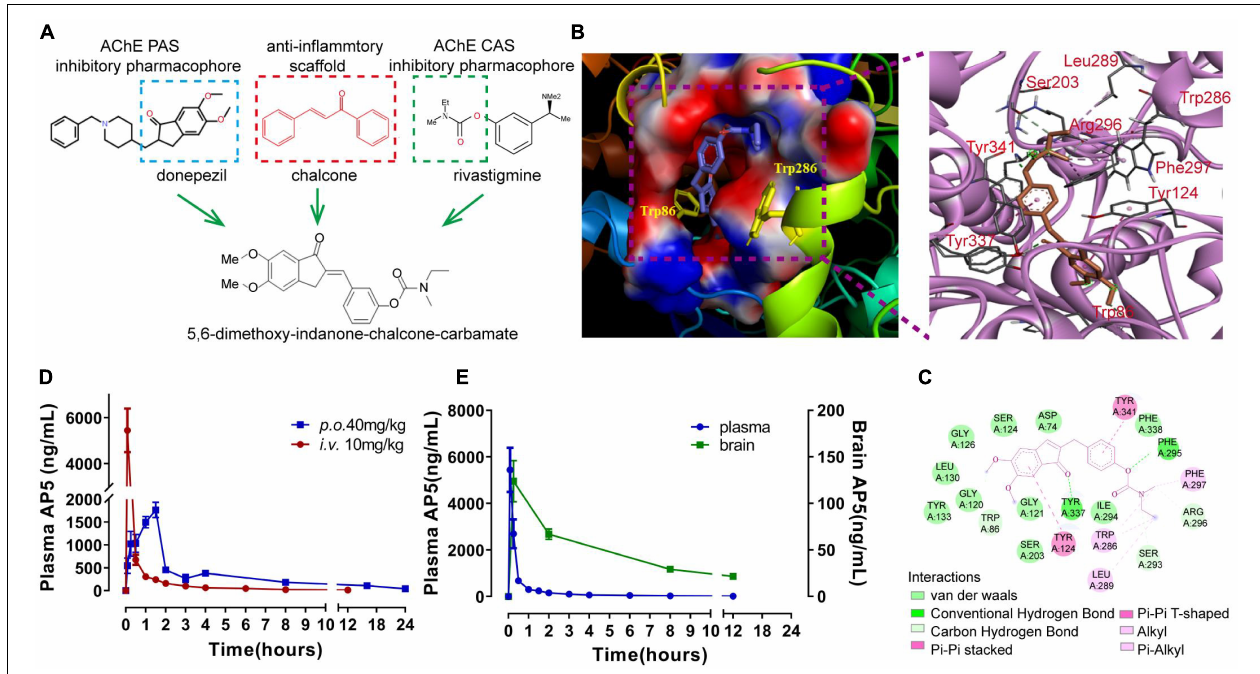
FIGURE 1 | Design, molecular docking, and pharmacokinetic evaluation of (E) -3-((5,6-dimethoxy-1-oxo-1,3-dihydro-2H-inden-2-ylidene)-methyl)phenylethyl(methyl) carbamate (named AP5). (A) Design strategy for AP5. (B) 3D docking diagram of AP5 and AChE active gorge (left), and the main amino acids involved in the interaction with AP5 (right). (C) 2D docking diagram of AP5 and AChE. (D) Line graphs showing changes in plasma concentration of AP5 after single-dose intravenous injection (i.v., 10 mg/kg) or per os ( p.o. , 40 mg/kg). Bioavailability (F%) after oral administration was calculated as AUC INF p . o . / AUC INFi . v . / 4 × 100%. AUC INF p . o . and AUC INFi . v . represent area under the plasma concentration-time curve extrapolated to infinity after single-dose per os and intravenous injection, respectively. (E) Line graphs showing changes in concentrations of AP5 in plasma and brain after single-dose oral administration (40 mg/kg). The extent of brain penetration was measured by brain-to-plasma distribution ratio (B/P). The B/P value was calculated as AUC INFbrain / AUC INF plasma × 100%. AUC INFbrain represents the area under the brain concentration-time curve extrapolated to infinity after a single-dose per os . n = 4 mice per time